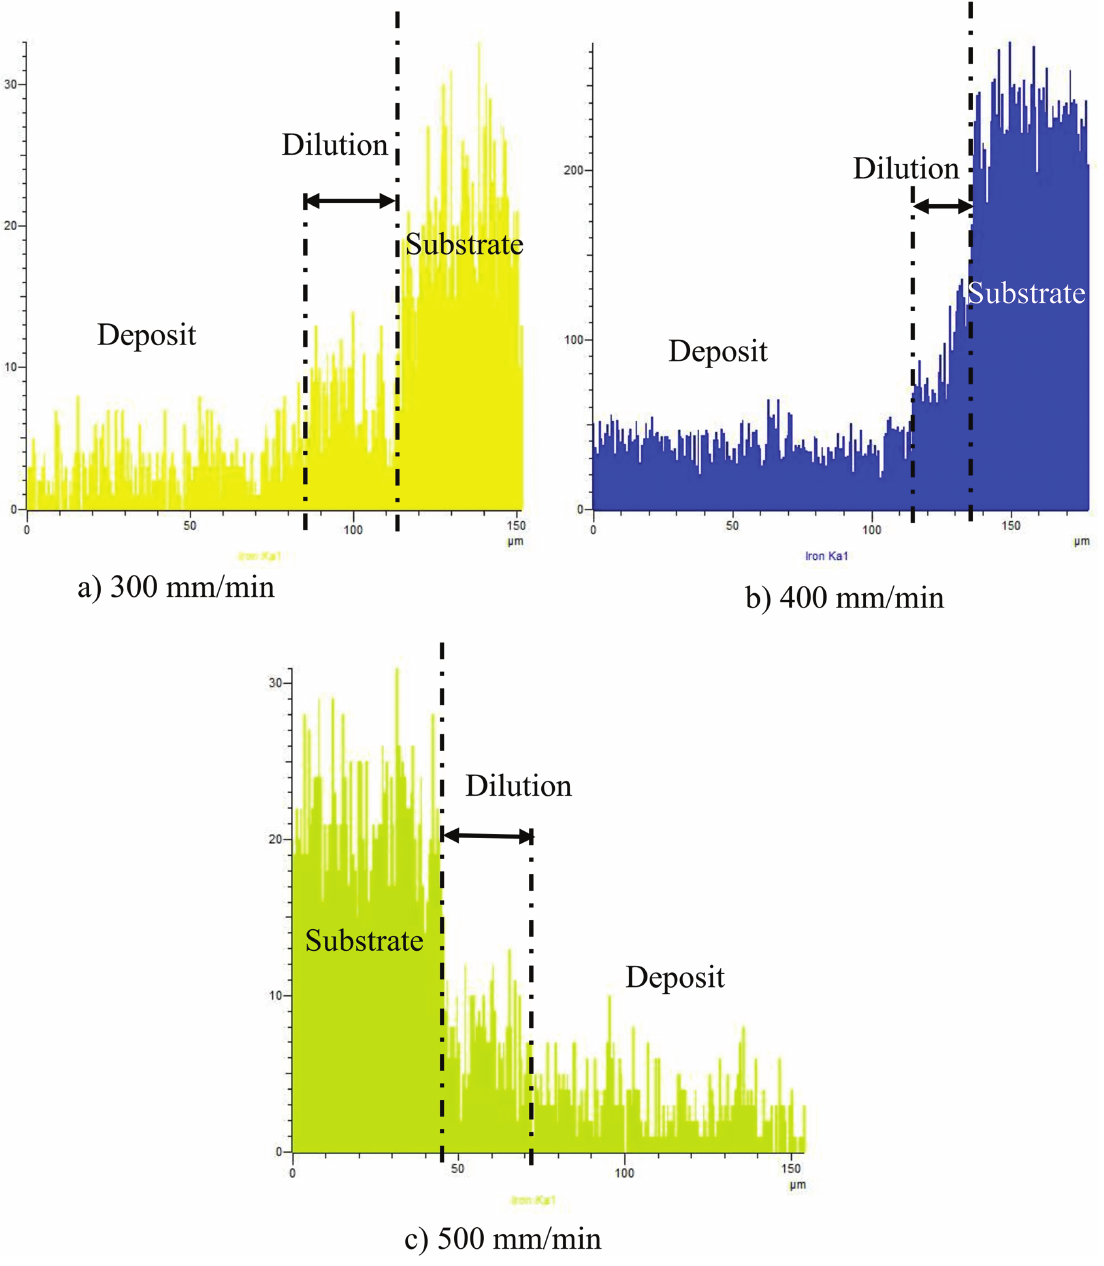
Figure 12: Effect of travel speed on Iron (Fe)